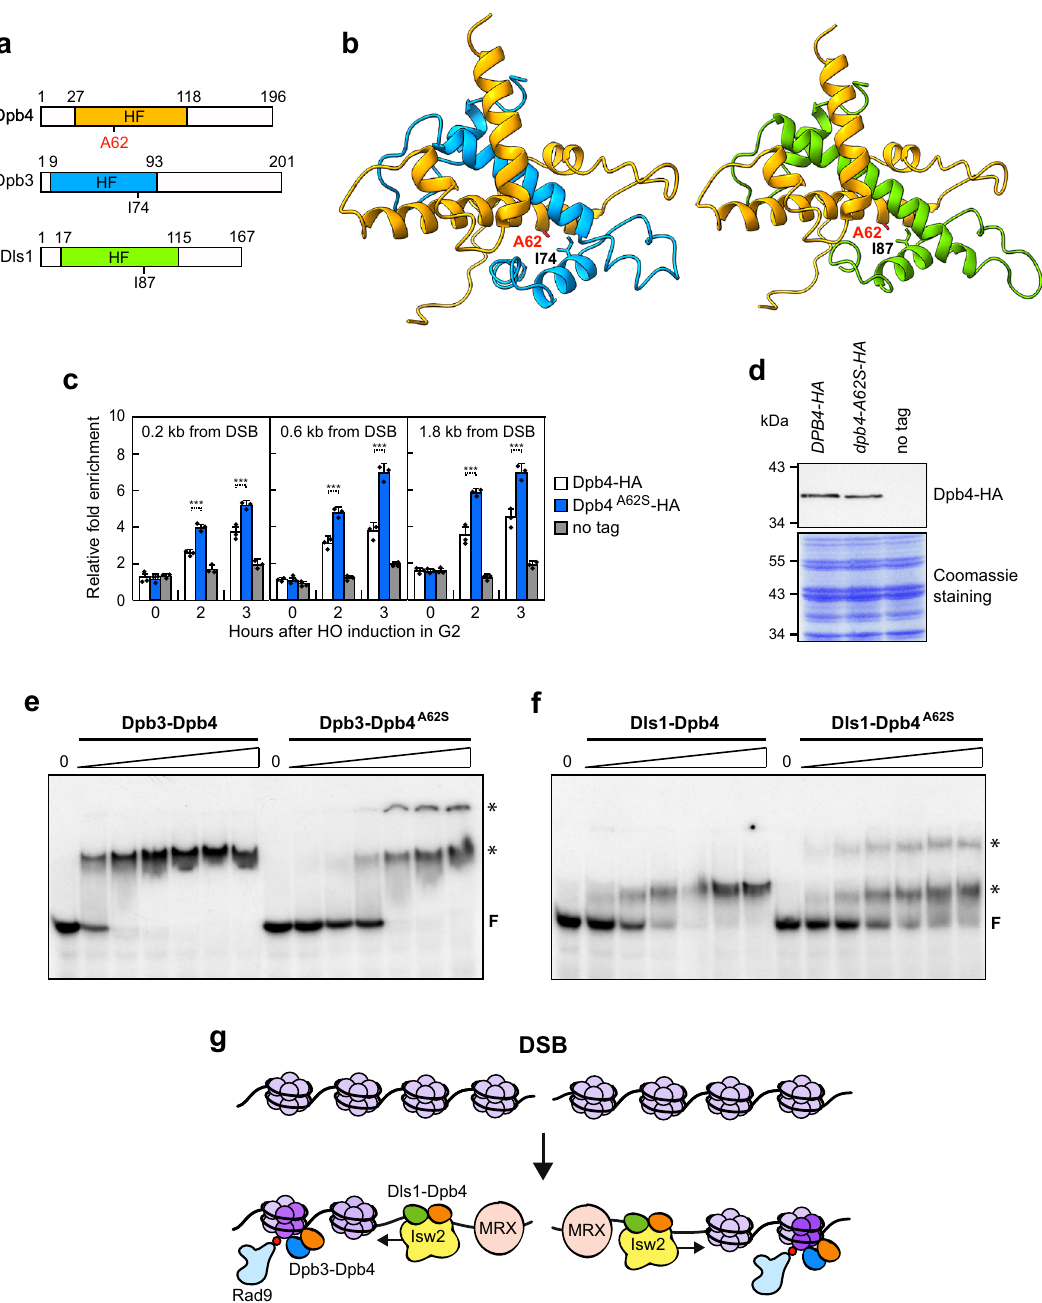
Fig. 8 Effect of the A62S mutation on the DNA binding properties of Dpb3 – Dpb4 and Dls1 – Dpb4 heterodimers. a Representation of Dpb4, Dpb3, and Dls1 proteins. The histone fold domain (HF) is shown. b 3D structure of Dpb4 – Dpb3 and Dpb4 – Dls1 heterodimers. The histone fold domain of Dpb4 is in orange, while that of Dpb3 and Dls1 is in light blue and green, respectively. A62 is shown as a red stick. The 3D structure of Dpb4 – Dpb3 was extracted from PDB 6WJV 35 , while the 3D model of Dls1 was built using I-TASSER 90 . c HO expression was induced at time zero by galactose addition to G2-arrested cells that were kept arrested in G2 by nocodazole. Relative fold enrichment of Dpb4-HA and Dpb4-A62S-HA compared to untagged Dpb4 (no tag) was evaluated after ChIP with anti-HA antibodies and qPCR analysis. The mean values of three independent experiments are represented with error bars denoting s.d. *** p < 0.005 (unpaired two-tailed Student ’ s t -test). d Western blot with anti-HA antibodies of protein extracts from G2-arrested cells. The experiment was performed independently three times with similar results. e , f EMSA with a 61 bp dsDNA and increasing concentrations of Dpb3 – Dpb4